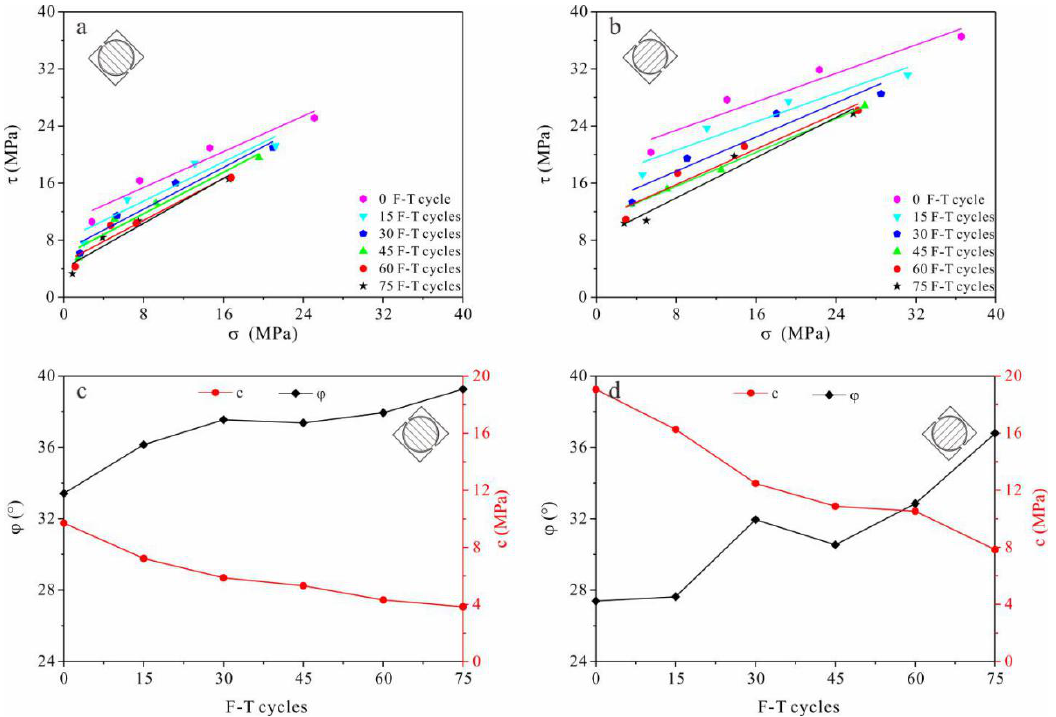
Figure 3. Variation in shear resistance with F-T cycles in sandstone samples with shear planes ( a , c ) parallel (S par ) and ( b , d ) perpendicular (S per ) to the bedding direction.